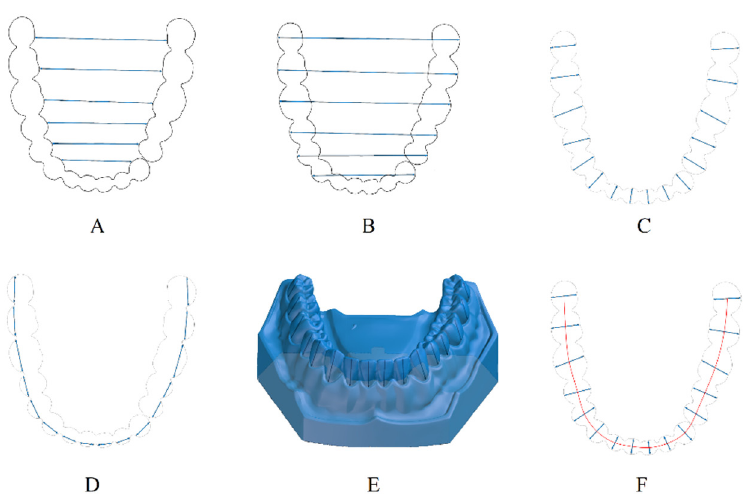
Figure 4. Schematic representation of measurement directions (features).